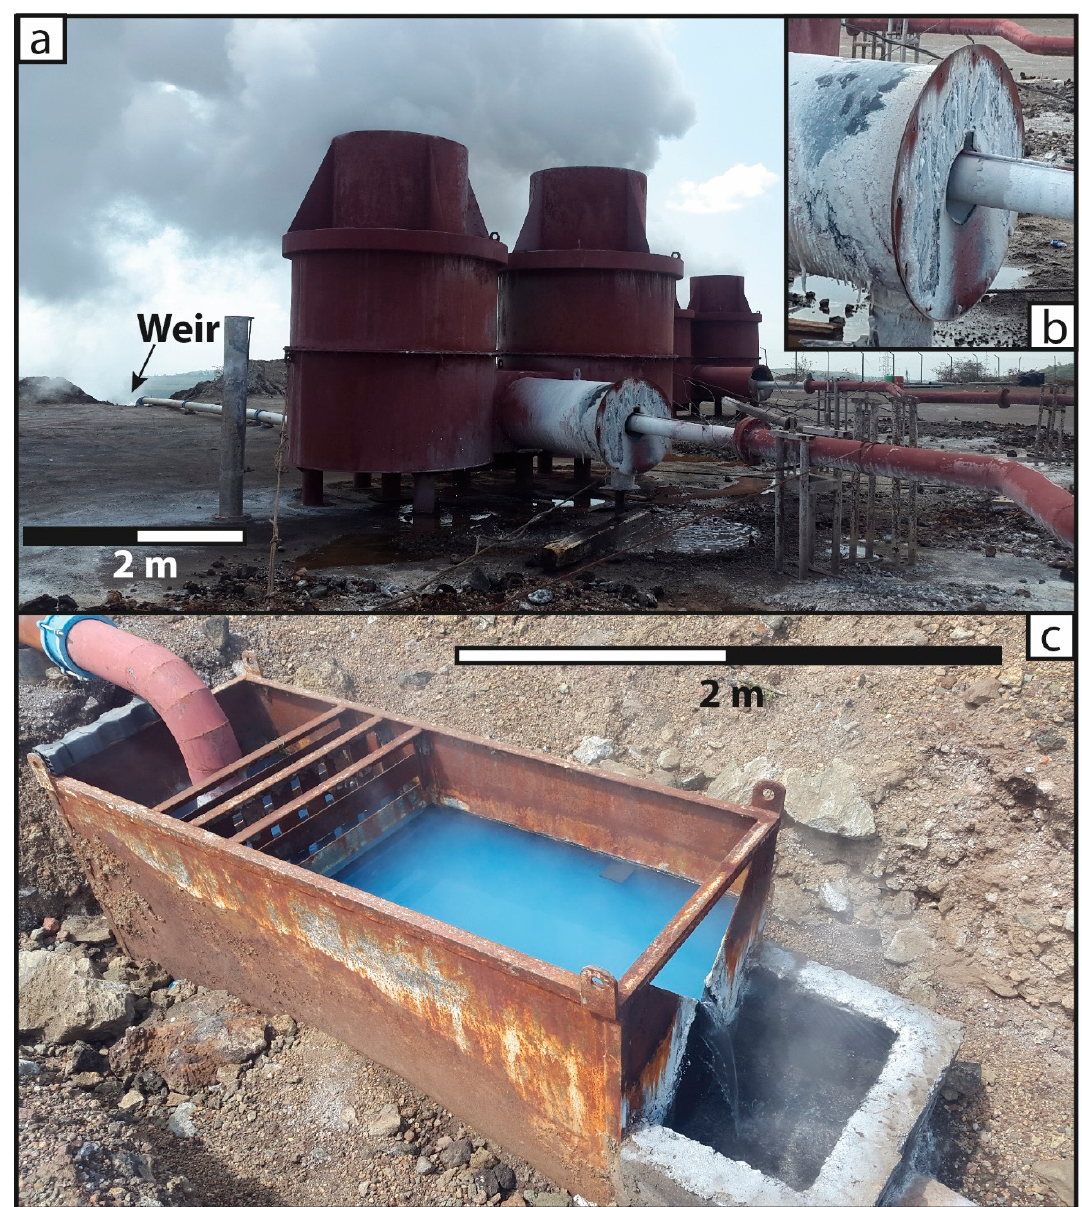
Figure 4. Menengai production test well infrastructure. ( a ) MW-17a (UTM 0171344, 9976440) flashing silencer and steam release chambers showing the weir sampling location. ( b ) Close-up of MW-17a silencer entry demonstrating significant silica precipitation. ( c ) Weir outlet and sampling location for MW-09 (UTM 0172910, 9976964). All images taken by